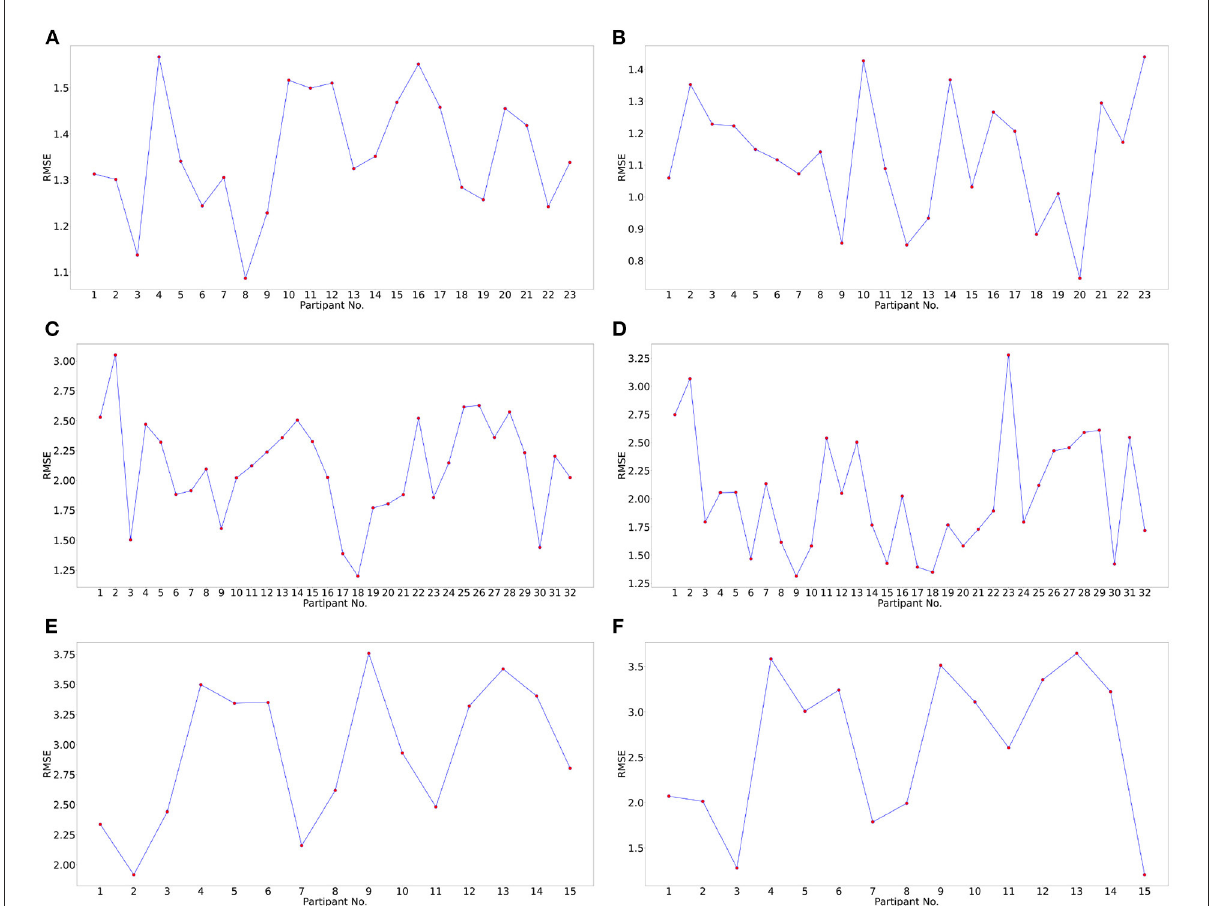
FIGURE5 Subject wise performance analysis for valence and arousal labels. Leave-one-subject-out cross-validation performance analysis for valence label for (A) DREAMER, (C) DEAP, (E) OASIS datasets and arousal label for (B) DREAMER, (D) , DEAP (F) OASIS datasets, respectively. In this cross-validation technique, one subject was chosen as the test subject, and the models were trained on the data of the remaining subjects.